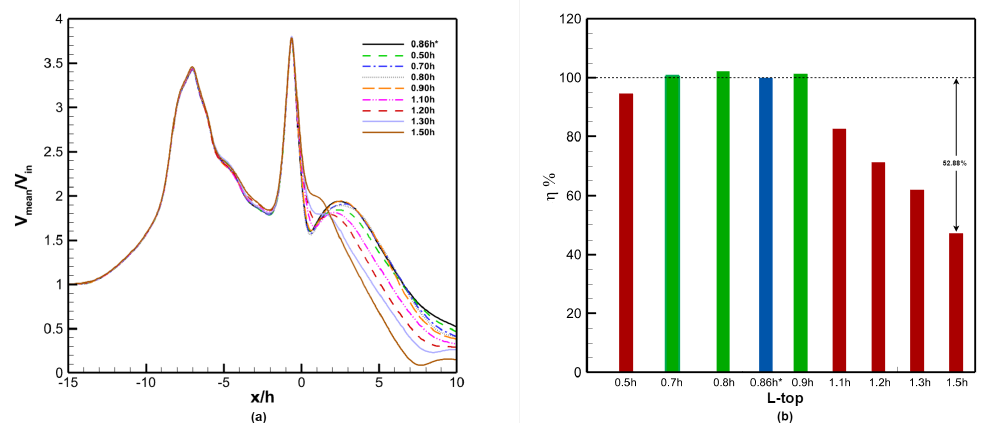
Figure 14. ( a ) Mean velocity along the centerline normalized by the inlet velocity, V in , Baseline ; ( b ) velocity ratio, η at point x/h = 5 for the L-top